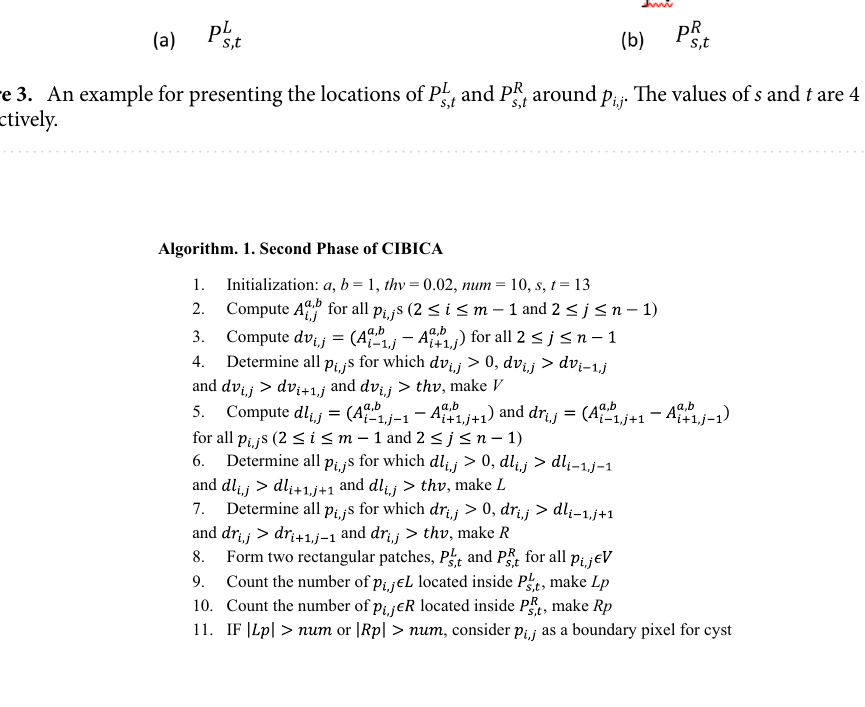
Figure 3. An example for presenting the locations of P